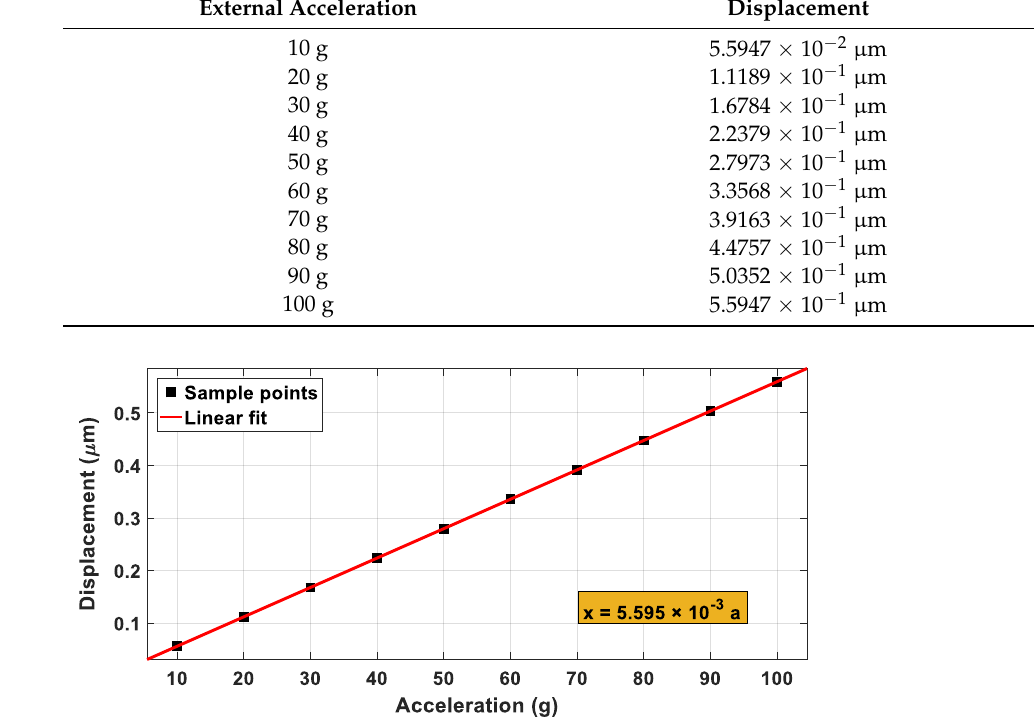
Table 3. Characteristic parameters of silicon carbide at different temperatures.